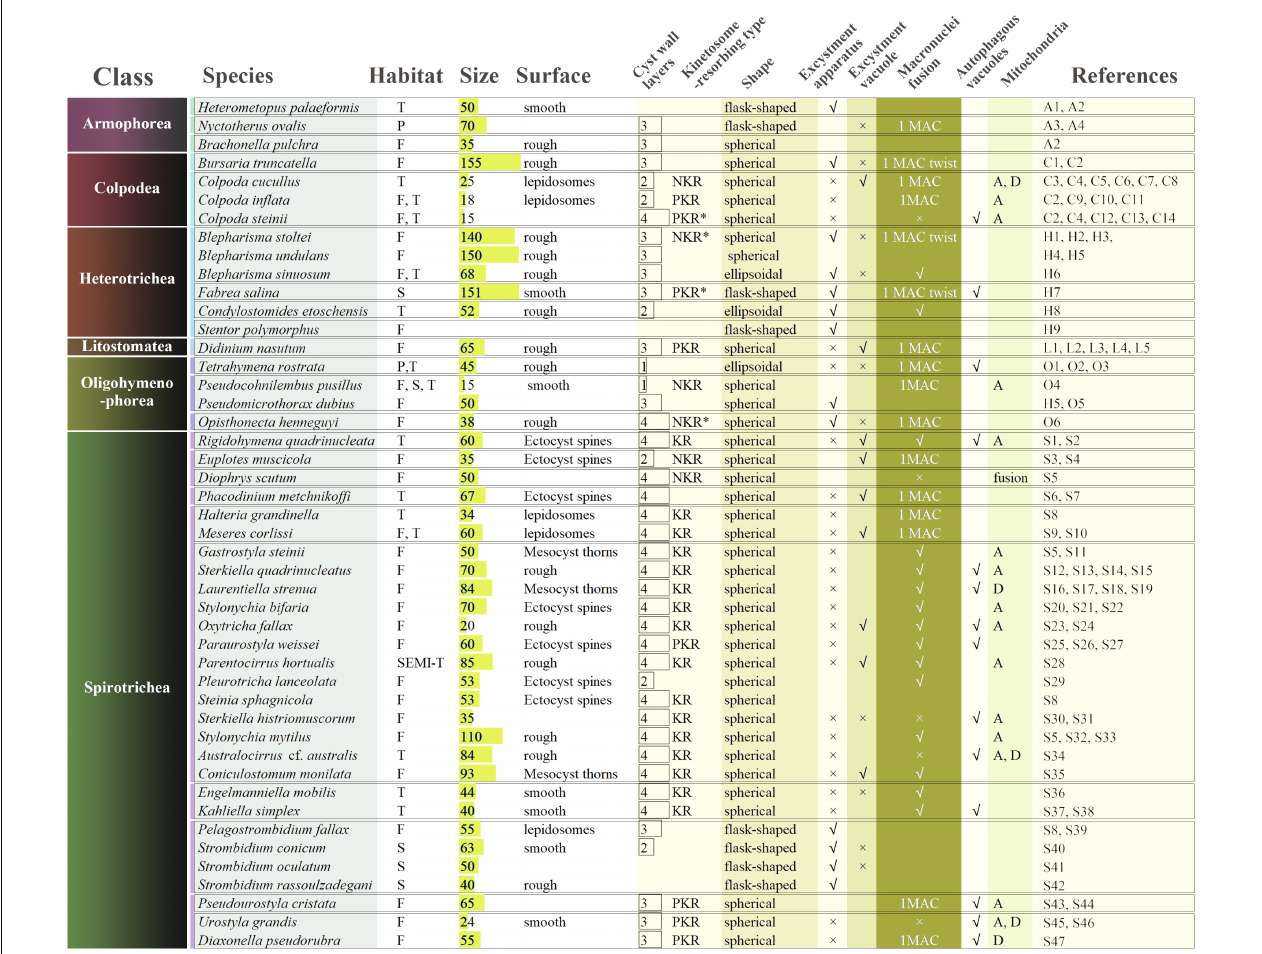
FIGURE 1 | Comparison of morphological characteristics of resting cysts of 46 ciliate species representing 6 classes. T, terrestrial; P, parasitic; F, fresh water; S, sea water; SEMI-T, semi- terrestrial; A, aggregation; D, degeneration; ∗ , classified by the present work. The detailed information of the references is shown in Supplementary Material